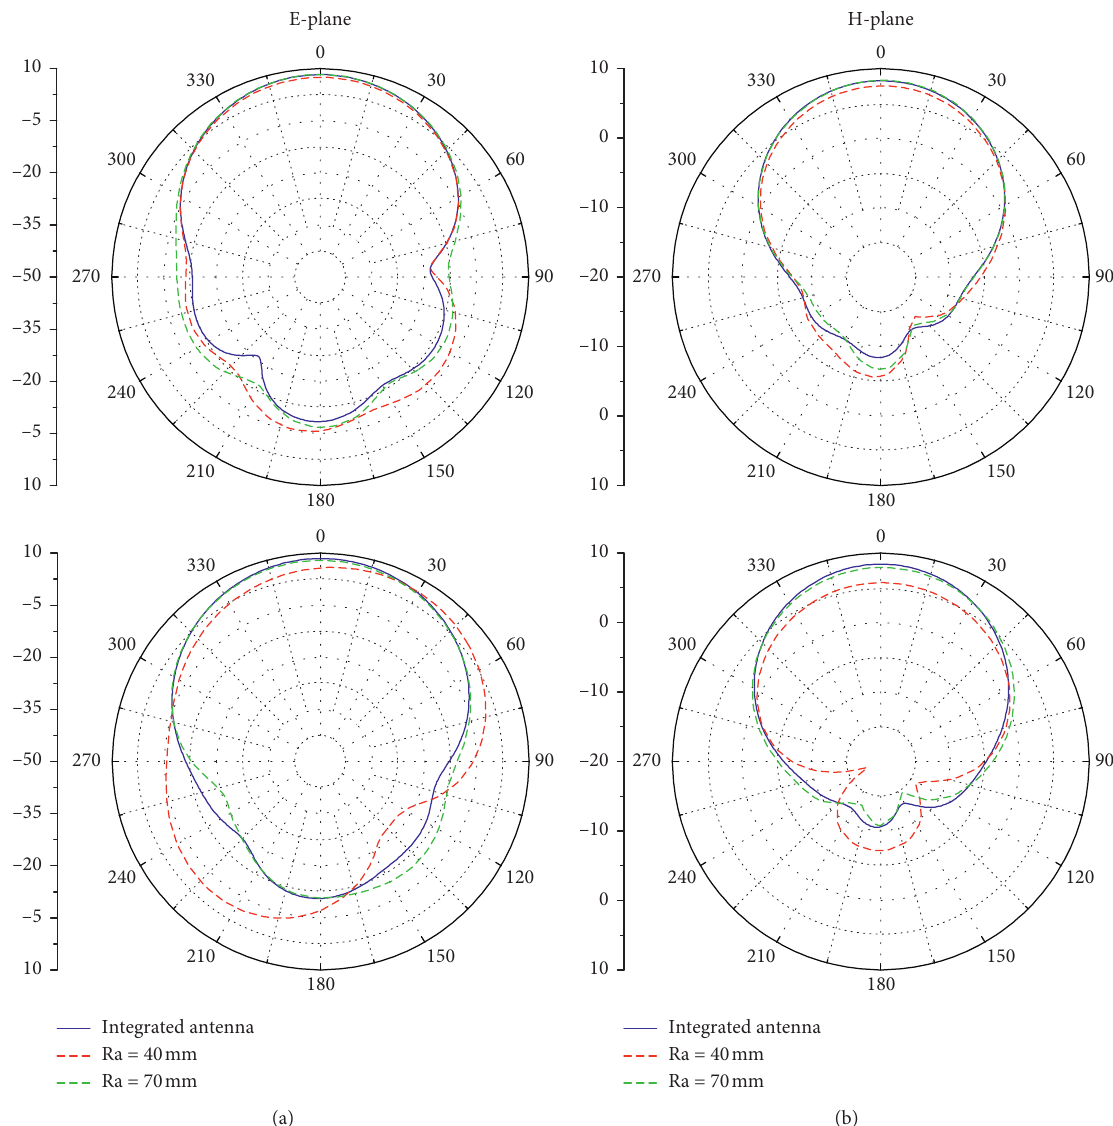
Figure 11: E- and H-plane gain total radiation patterns of structurally deformable wearable antenna: (a) 5.2GHz and (b) 5.8